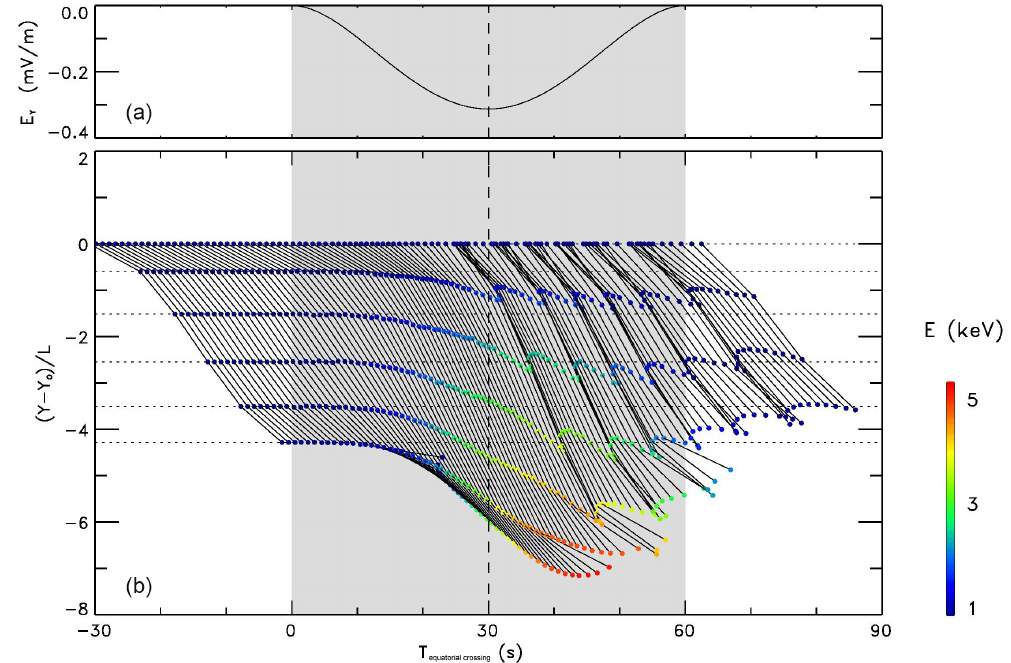
Figure 3. Bottom: Y locations of H + equatorial crossings as a function of equatorial crossing time. The Y coordinate is evaluated with respect to the first midplane crossing and normalized to the half thickness of the current sheet, L . The instantaneous H + energy is coded according to the color scale on the right. Top: electric field as a function of time. A 60s (shaded area) magnetic transition is